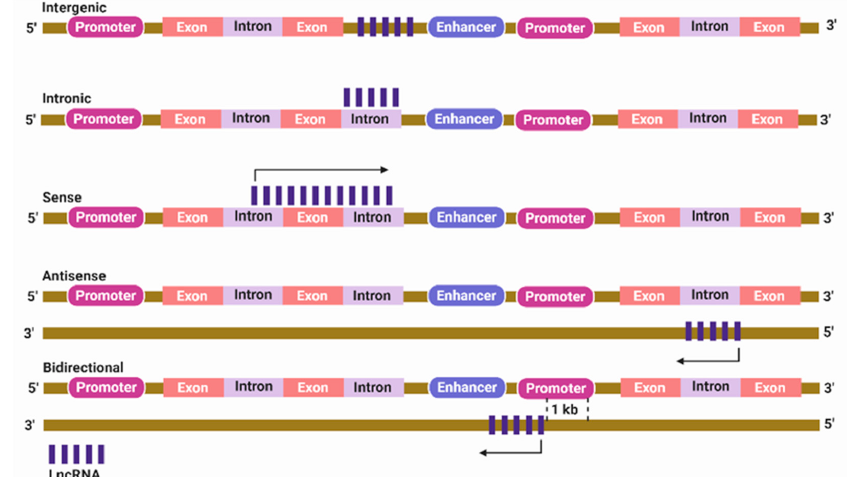
Figure 1. Classification of long non-coding RNAs (lncRNAs) based on their genomic location. Intergenic lncRNA is located between two protein-coding genes. Intronic lncRNA lies entirely within the intron of a protein-coding gene. Sense lncRNA is transcribed from the same strand and in the same direction as the nearby protein-coding genes. Antisense lncRNA is transcribed from an opposite strand. Bidirectional lncRNA is located within 1 kb of the promoter region of a protein-coding gene but is transcribed from an opposite strand.